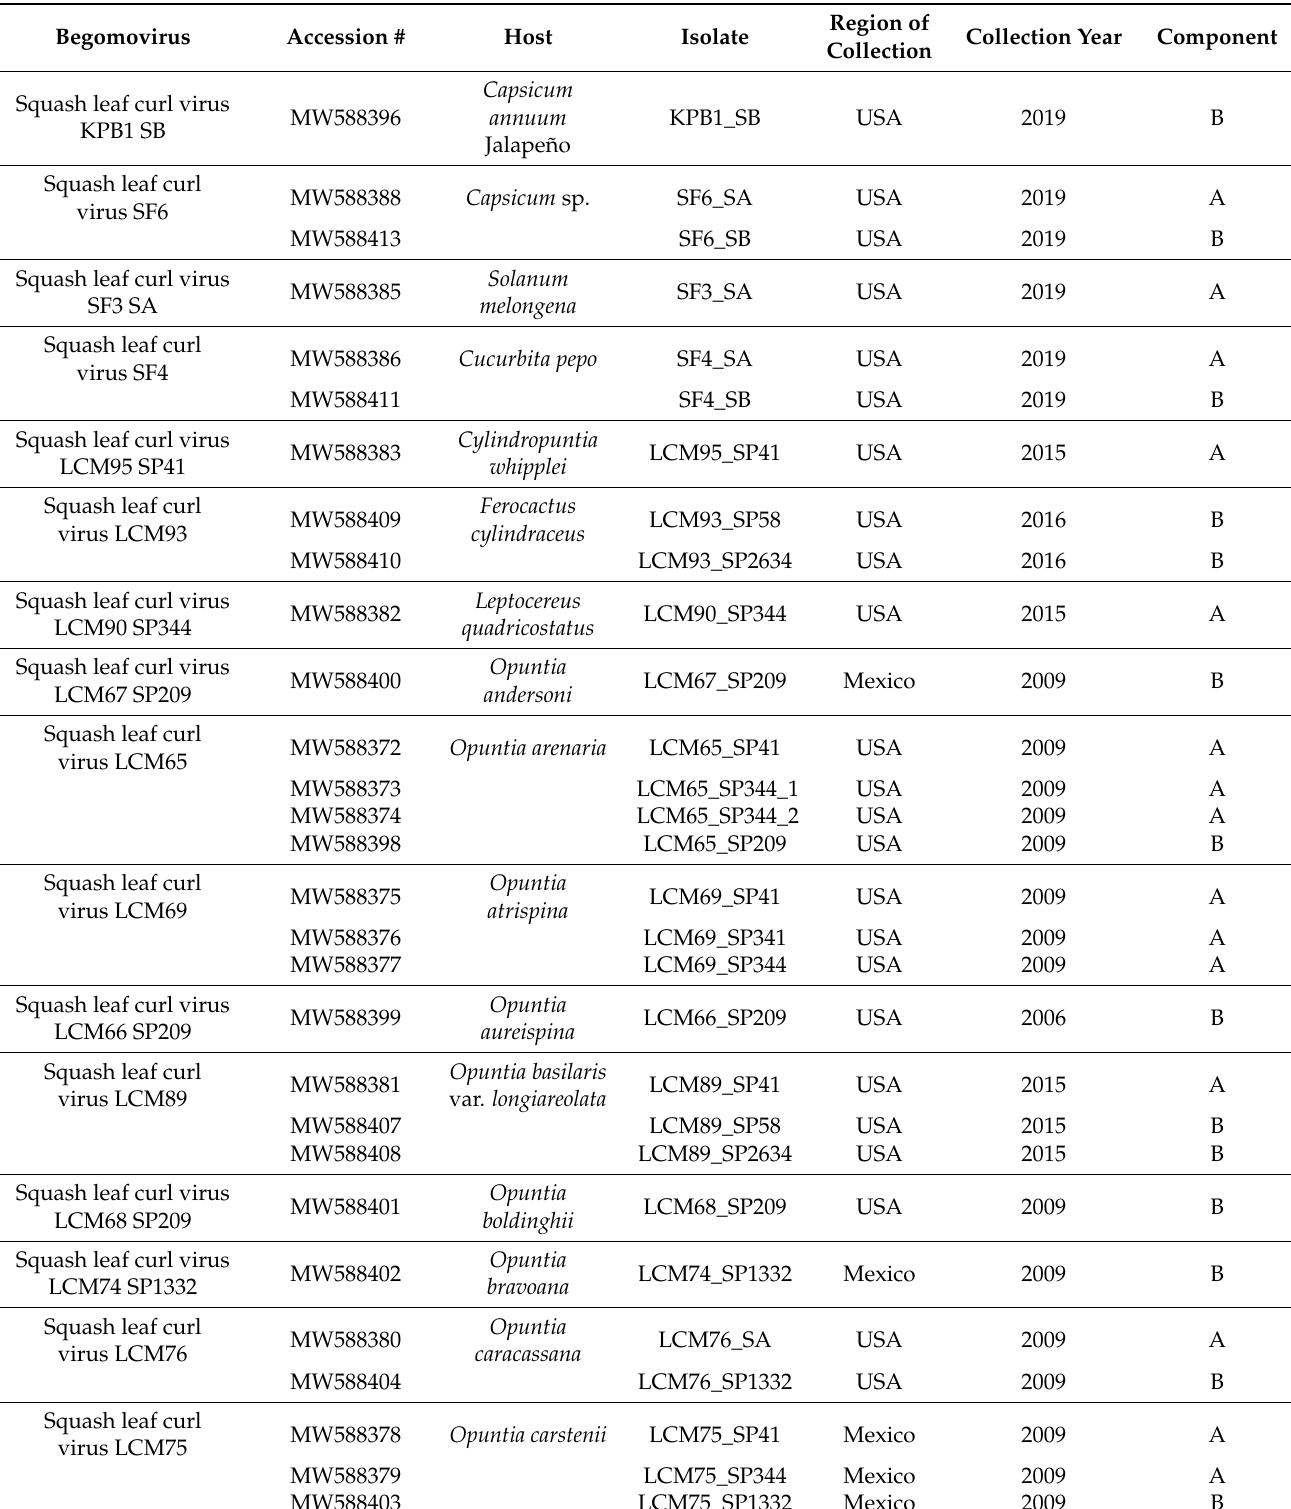
Table 1. Summary of the begomovirus components identified in each plant host, including the host family species, country and year of